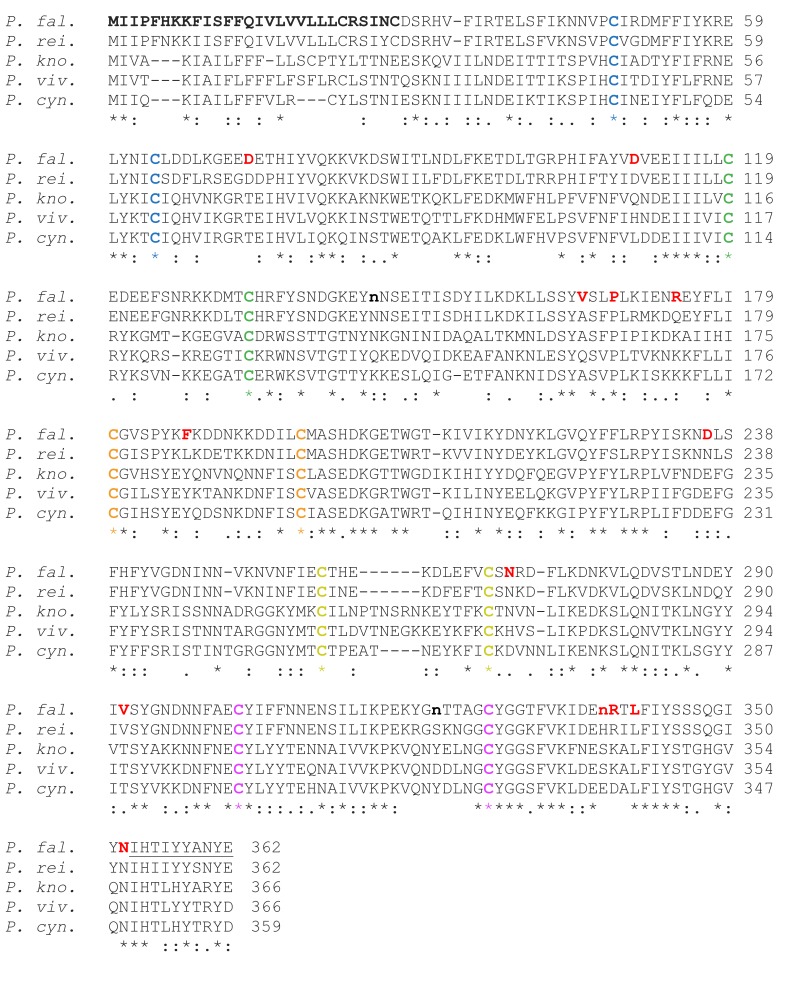
Sequence alignment of CyRPA orthologs.Sequence alignment of CyRPA orthologs from P. falciparum (P. fal.), P. vivax (P. viv.; PVX_090240), P. knowlesi (P. kno.; PKNH_0515800), P. cynomolgi (P. cyn.; PCYB_053730), and P. reichenowi (P. rei.; PRCDC_0421000). Full-length protein sequences (PlasmoDB; plasmodb.org/plasmo) were aligned with Clustal O (1.2.1). Asterisks indicate conserved positions, colons indicate strong biophysical conservation, and periods indicate weak biophysical conservation. Ten of the twelve Cys residues are conserved (same color code as in Figure 3). The predicted PfCyRPA secretion signal sequence (M1–C28) is indicated in boldface, and the predicted GPI-anchor motif (I353-E362) is underlined. The N-glycosylation sites that are used in human cells (N145, N322, and N338) are shown in lowercase and the non-synonymous SNPs (D73, D110, V165, P168, R174, F187, D236, N270, V292, N338, R339, L341, N352) are colored in red.